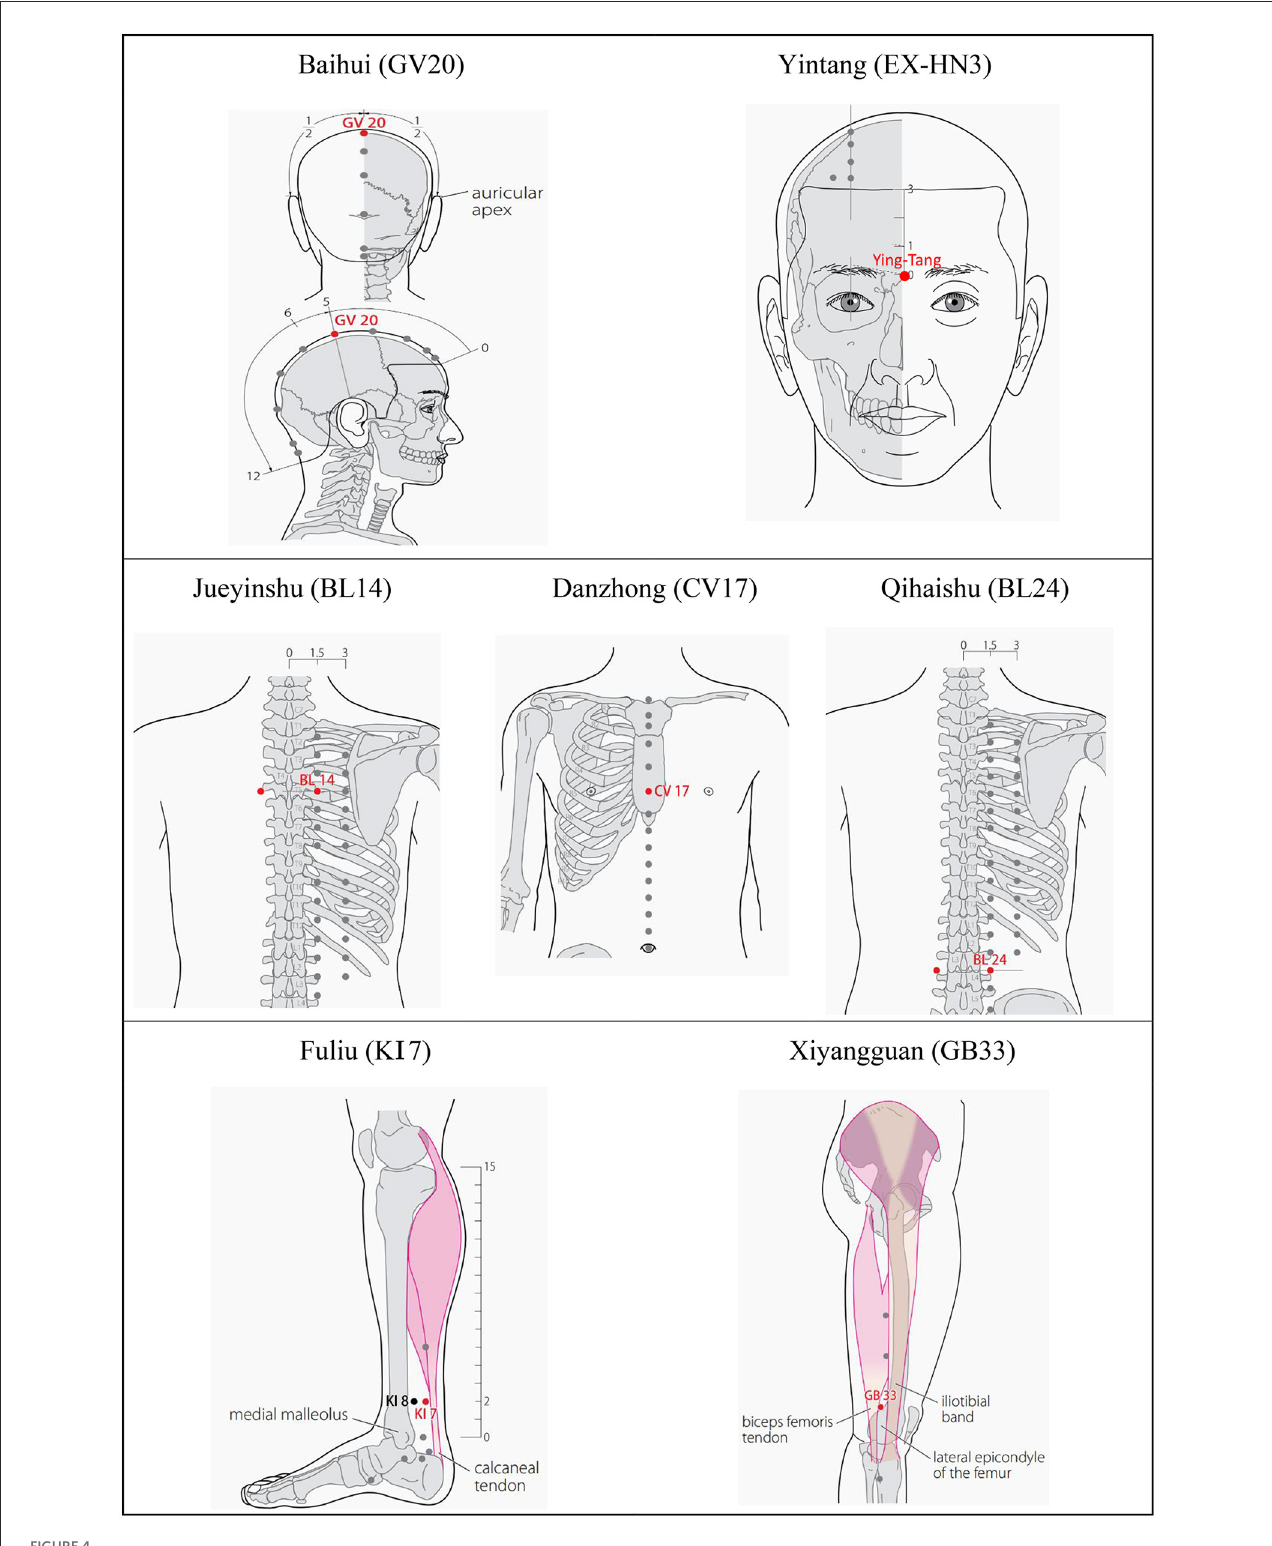
FIGURE4 Location of